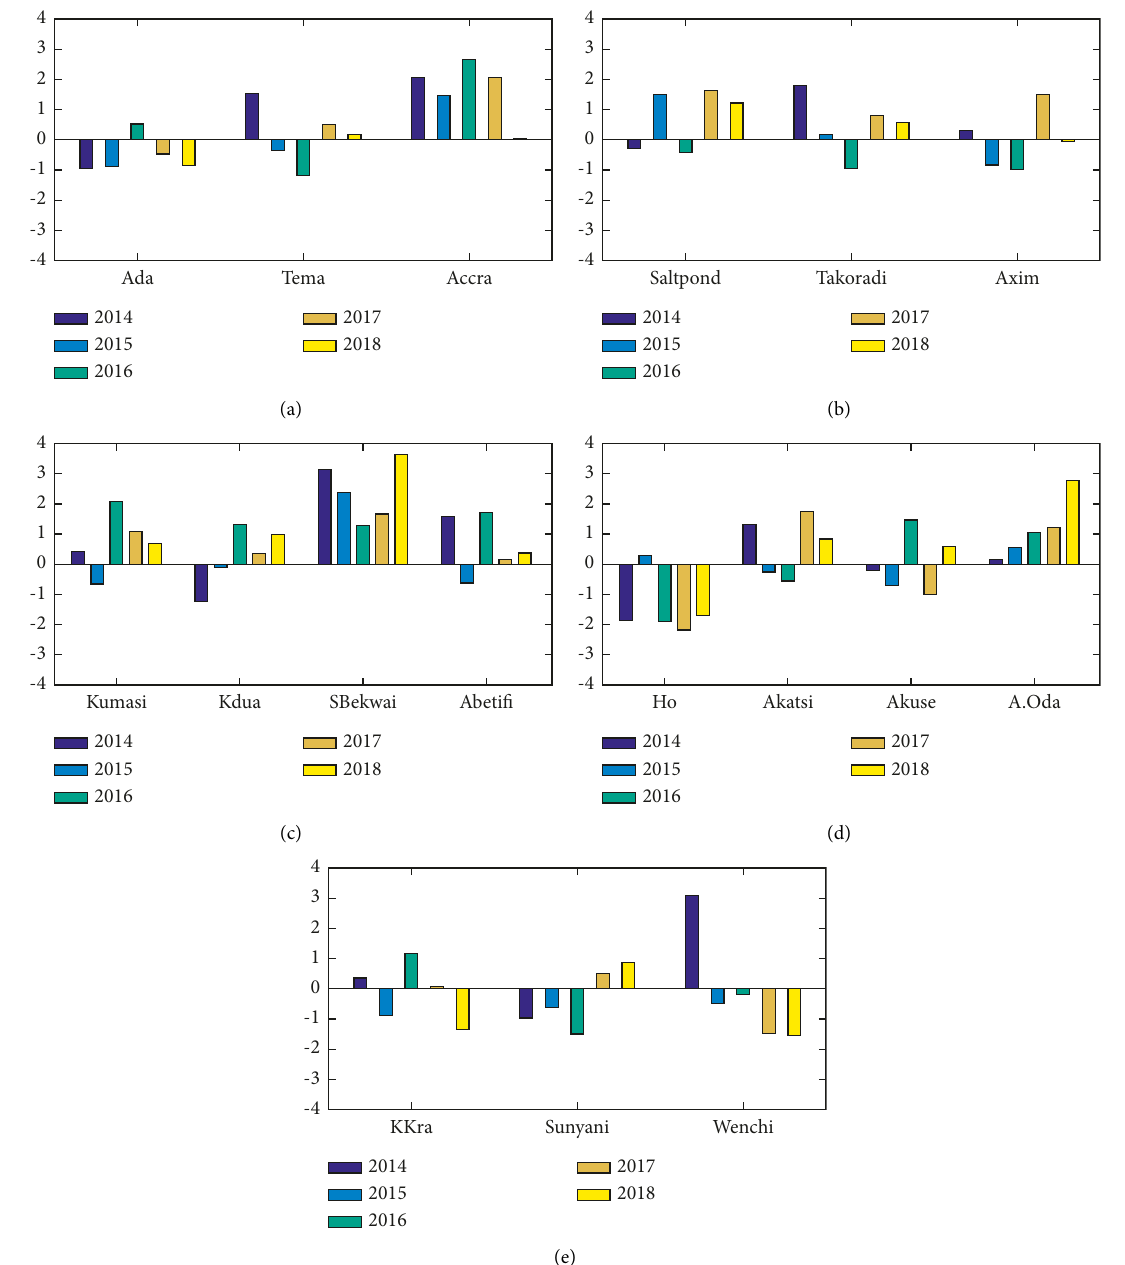
Figure 7: Standardized rainfall anomaly indices for the minor season. (a) East Coast, (b) West Coast, (c) Middle Sector, (d) Middle Sector, and (e) Transition Zone. Data used: in situ rainfall data from the Ghana Meteorological